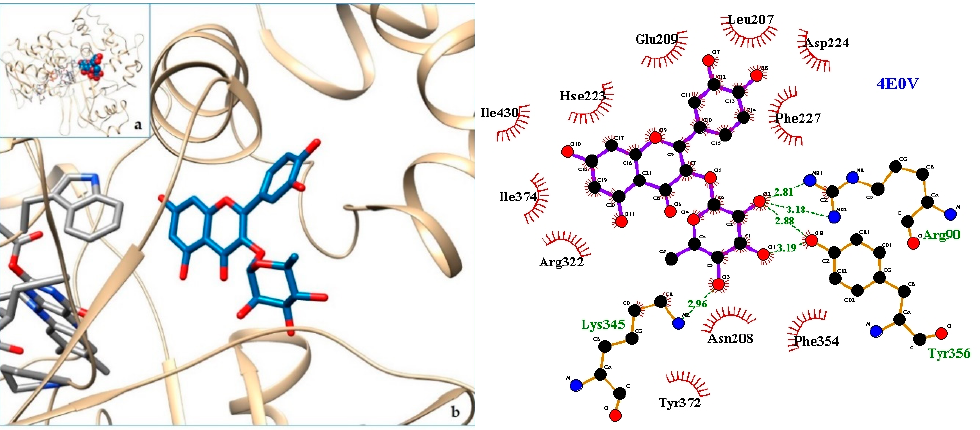
Figure 9. 1XXS-quercetrin complex in the most favourable arrangement ( a ) and augmented ( b ) showing the disposition between the chain of toxins. Right: 2D interaction diagram.